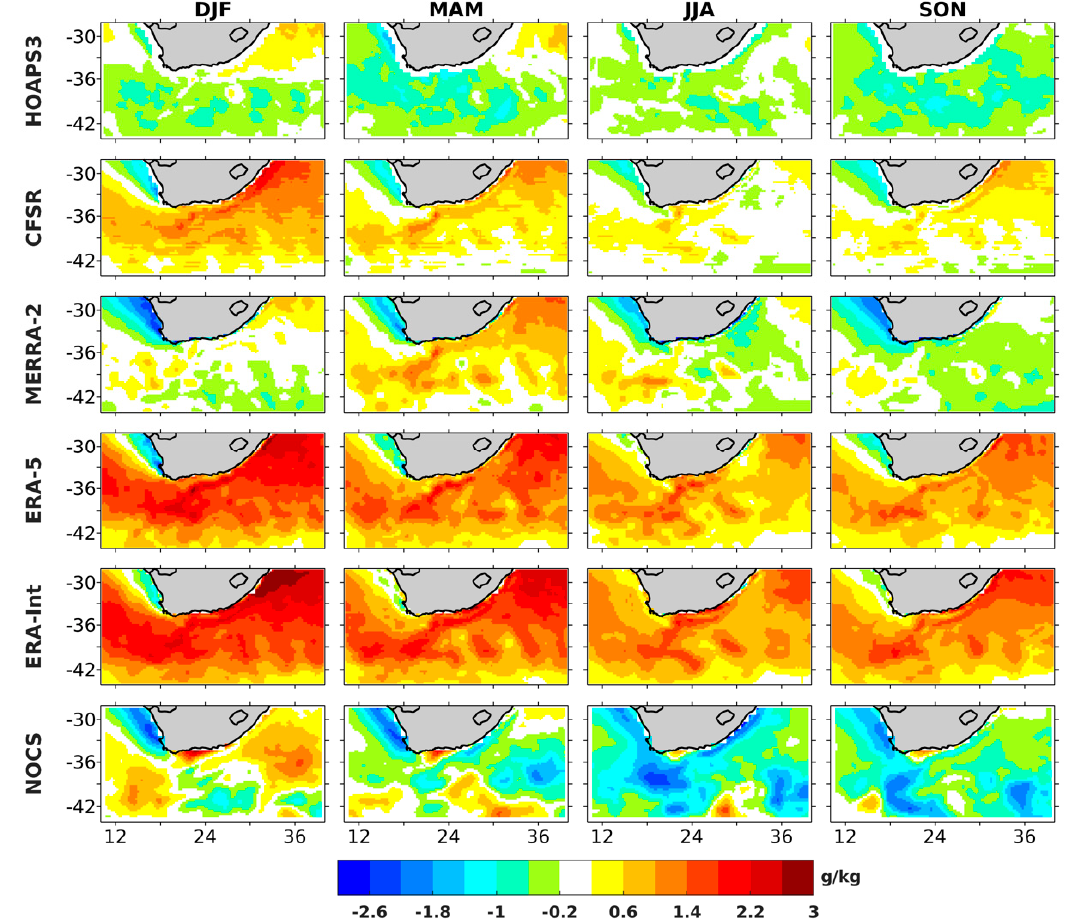
Figure 15 : Mean seasonal differences of Qss-Qa (g/kg) between HOAPS3, CFSR, MERRA-2, ERA- Interim, NOCS and SEAFLUX. From left to right austral summer (DJF), austral autumn (MAM), austral winter (JJA) and austral spring (SON).